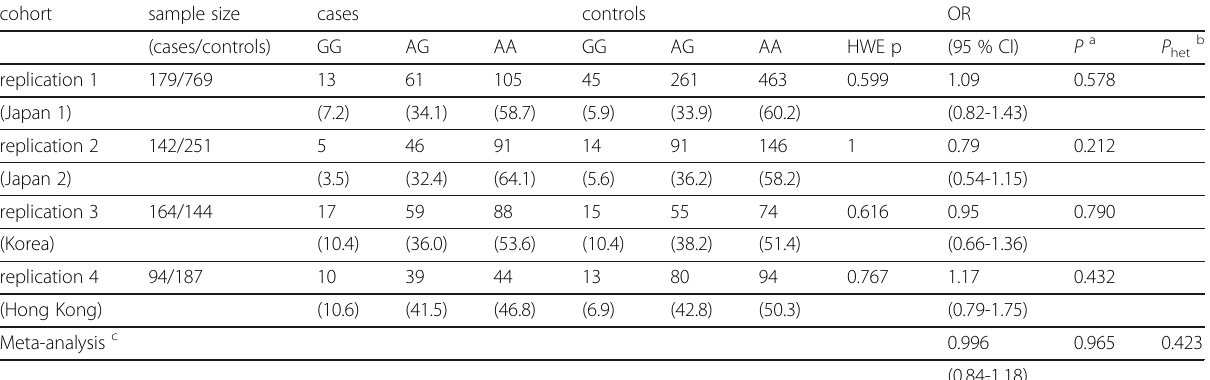
Table 1 Association between rs17401966 and HBV-derived HCC